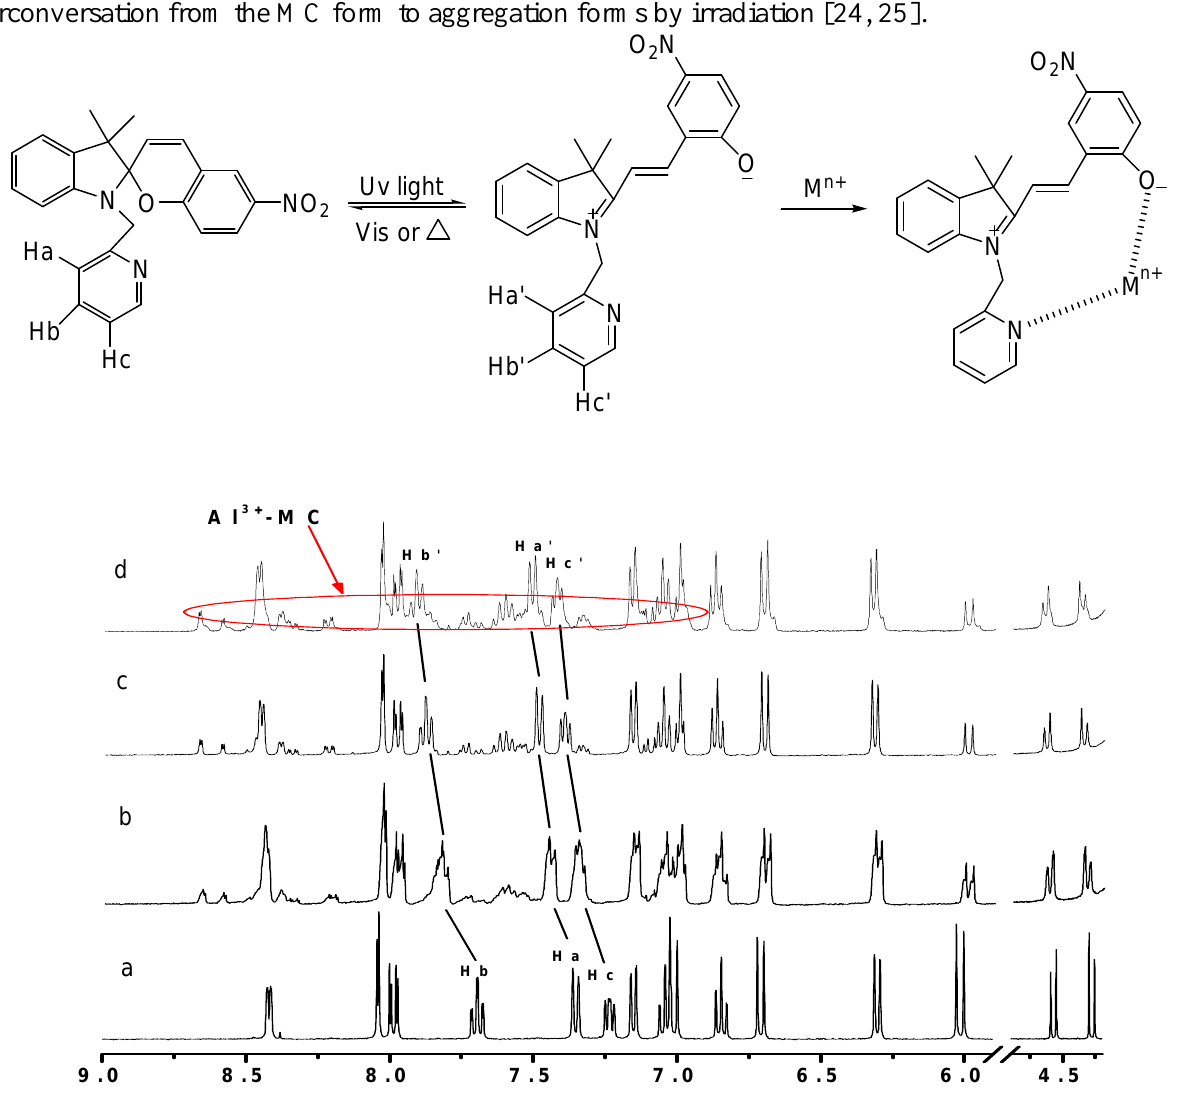
CN/D O = 8:2, V/V) of spiropyran without Al 3+ (a), 3 2 (c), and 1 eq